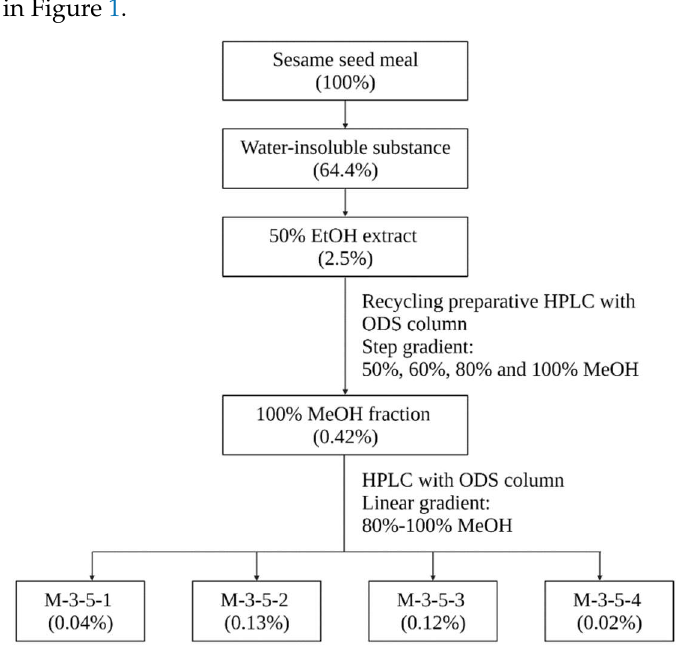
Figure 1. Flow chart illustrating the extraction, fractionation, and purification of pancreatic lipase-inhibitory compounds from sesame meal by sequential solvent extraction and HPLC. The percentages in parentheses denote the yields. EtOH: ethanol; MeOH: